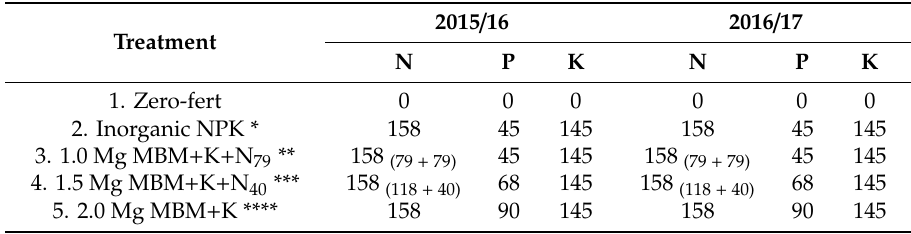
Table 1. Rates of nitrogen (N), phosphorus (P) and potassium (K) applied with meat and bone